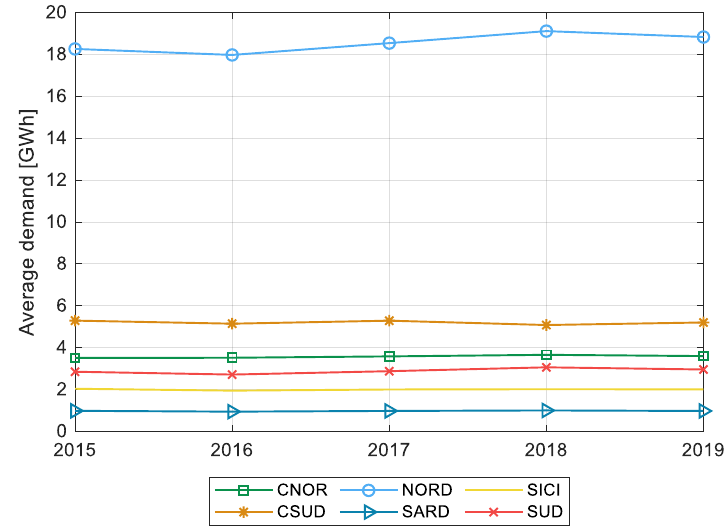
Figure 3. Average zonal demand trend for the period 2015 – 2019 [25].